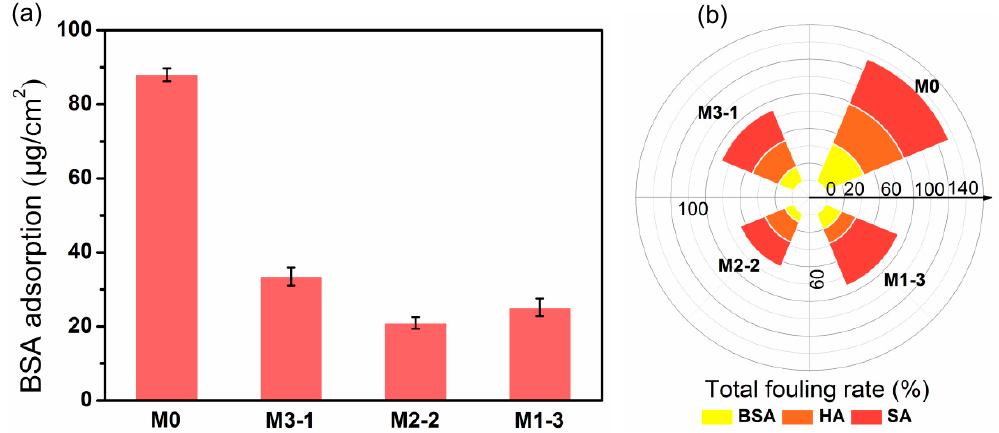
Figure 9. ( a ) Amounts of protein adsorbed onto membranes and ( b ) total fouling rate ( R t ) of dynamic filtration.